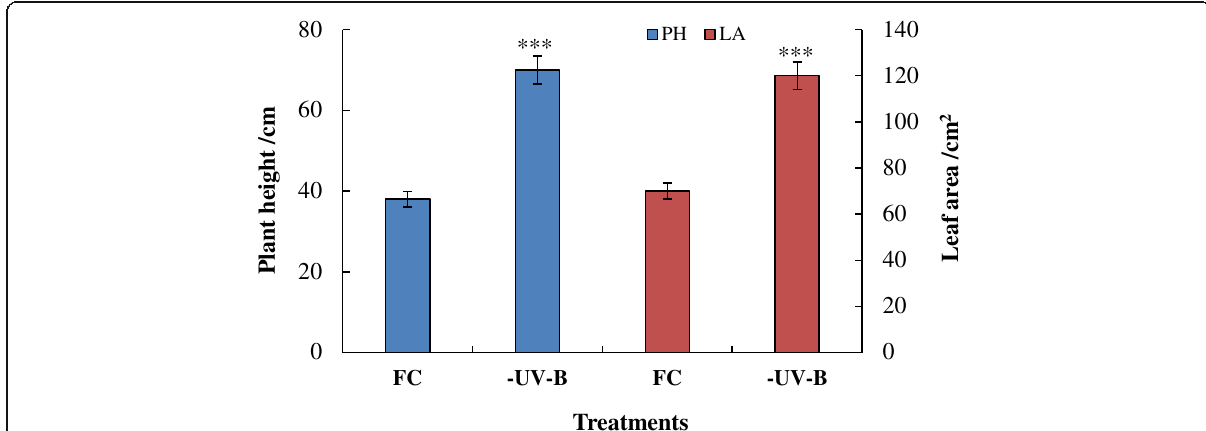
Fig. 3 Effect of exclusion of UV-B on plant height and leaf area of cotton seedlings var. Vikram grown in filter control (FC) and UV-B excluded conditions. The vertical bar indicates ±SE for mean. Values are significantly different at *** P <0.001 from filter